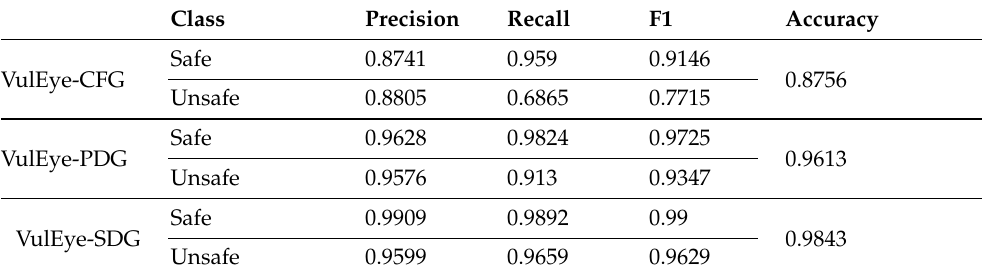
Table 9. Different representation methods’ results comparison. Class Precision Recall F1